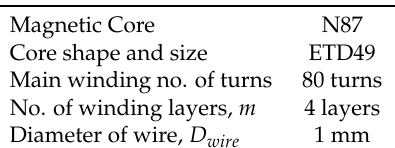
Table 4. Specifications of the inductor prototype developed to validate the winding model.